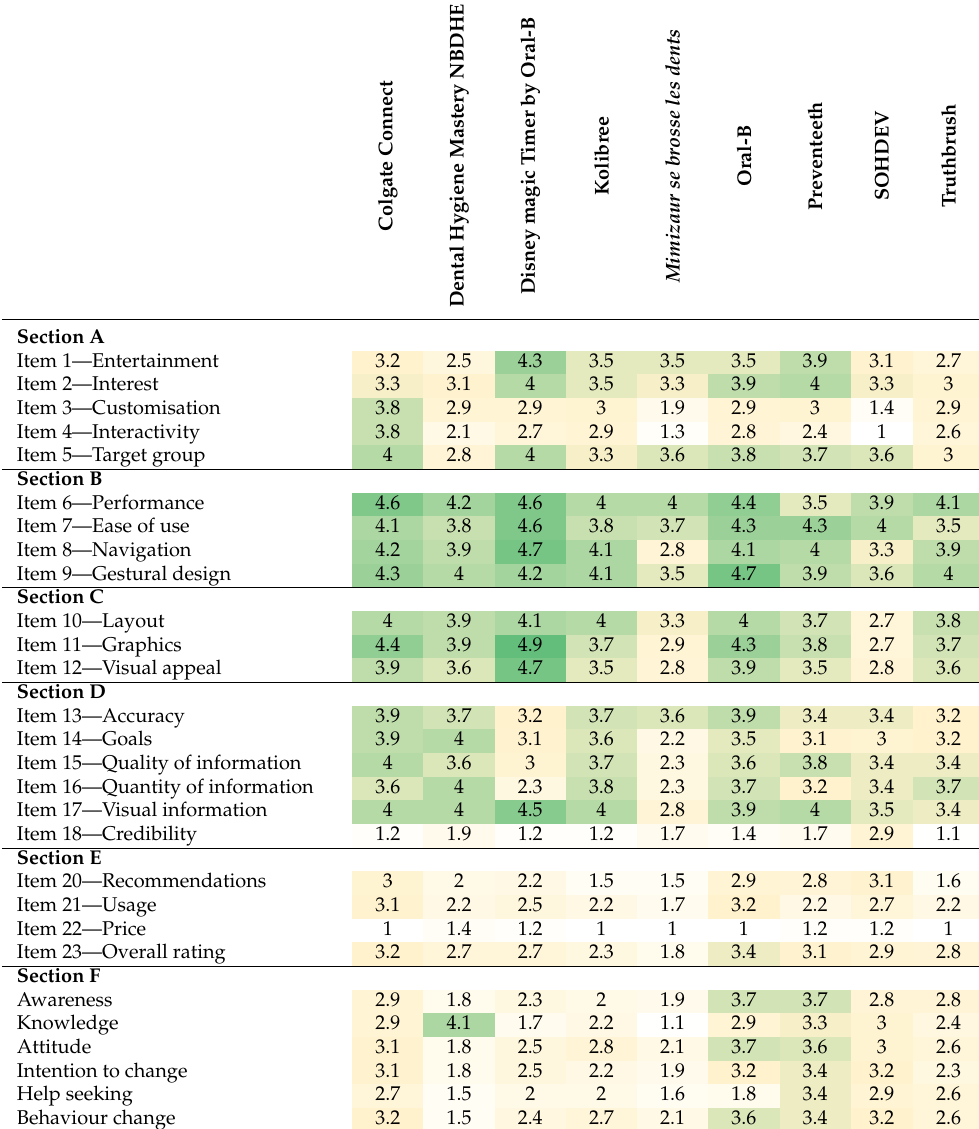
Table 2. Heatmap of the average scores per item and per app. The colors are related to the scores and go from yellow (1: worst score) to green (5: best score).